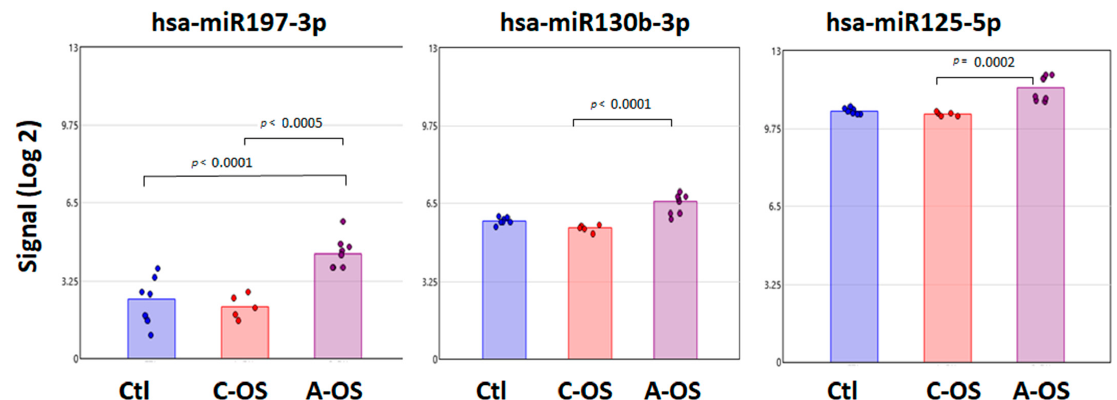
Figure 4. Individual changes in expression of exosomal miRNAs predicted to target PPP2CA . Bar plots depict the Affymetrix signal of hsa-miR197a-3p, hsa-miR130b-3p, and hsa-miR125b-5p in NPCE cells derived-exosome following chronic C-OS or A-OS. Each group contains a minimum of five independent replications. One-way ANOVA was performed and identify the p < 0.001 among to